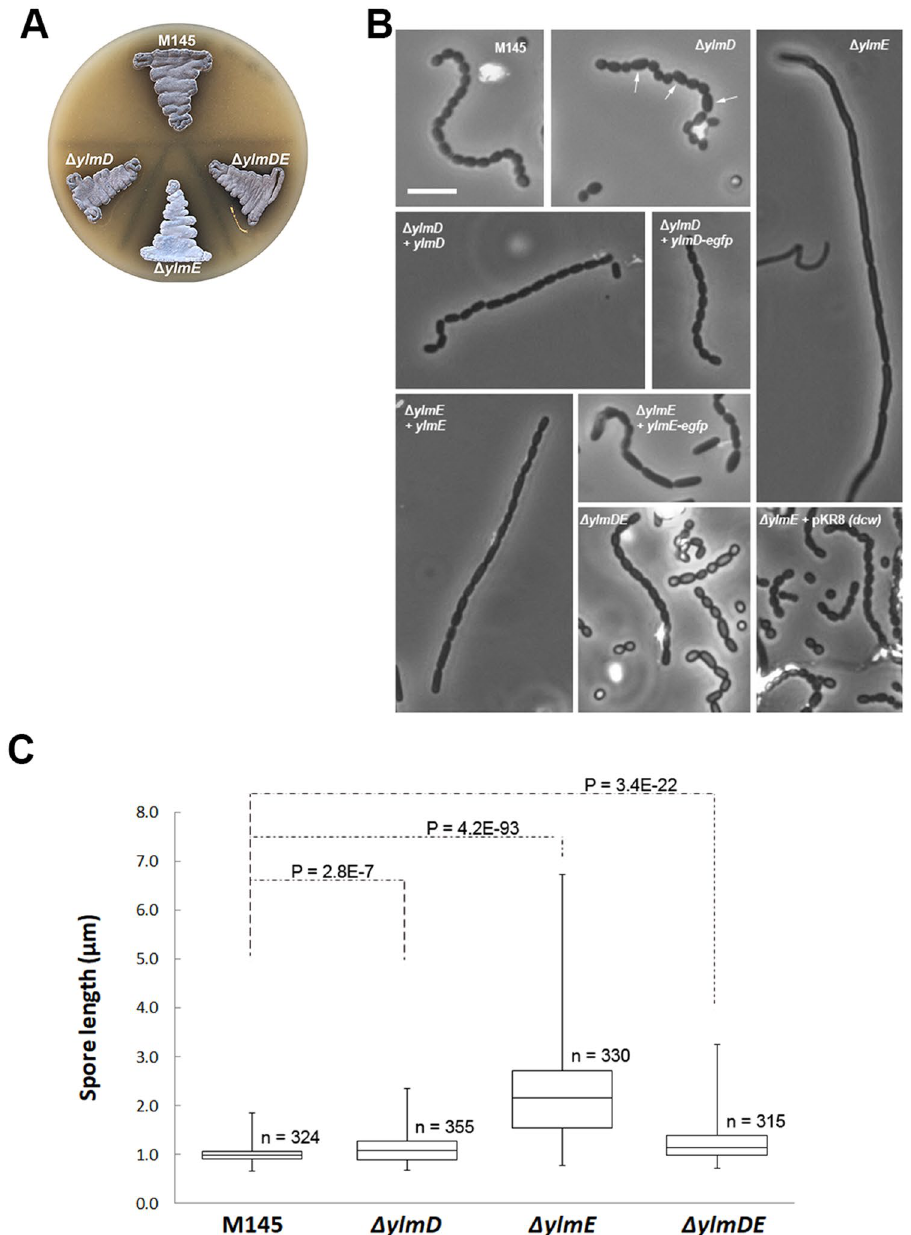
Figure 2. Phenotype of the S. coelicolor ylmD and ylmE mutants. ( A ) sporulation of S. coelicolor M145 and its ylmD , ylmE and ylmDE mutants on SFM agar after 5 days incubation. Note the lack of grey pigmentation of the ylmE mutant, indicative of a sporulation defect. ( B ) phase-contrast micrographs of impression prints of the strains shown in (A) as well as the complemented mutants. Arrows point at irregularly shaped spores in the ylmD mutant. The sporulation defect of the ylmD mutant could be complemented by introduction of wild-type ylmD and ylmD- eGFP , while complementation of the ylmE mutant by wild-type ylmE or ylmE-egfp restored sporulation, although irregularly sized spores were often produced. Full complementation of ylmE mutants was obtained by introduction of pKR8, which contains part of the S. coelicolor dcw cluster. Bar, 5 μ m. ( C ) Size distributions of wild-type spores and those of ylmD, ylmE and ylmDE mutants presented as boxplots. Data are presented as median and interquartile range in boxplots, with whiskers spread to the maximal and minimal values. The numbers (n) of spores measured for each strain are indicated. Assessment of normality of spore length data was performed by a Kolgomorov- Smirnov test, the results showing that spore length data for all mutants followed non-normal distribution ( D max > D crit). The shown two-tailed P values between each mutant and the parental strain were calculated using a Mann-Whitney U test. The two-tailed P values were far below 0.05, which shows that the sizes of the mutant spores deviated significantly from those of wild-type